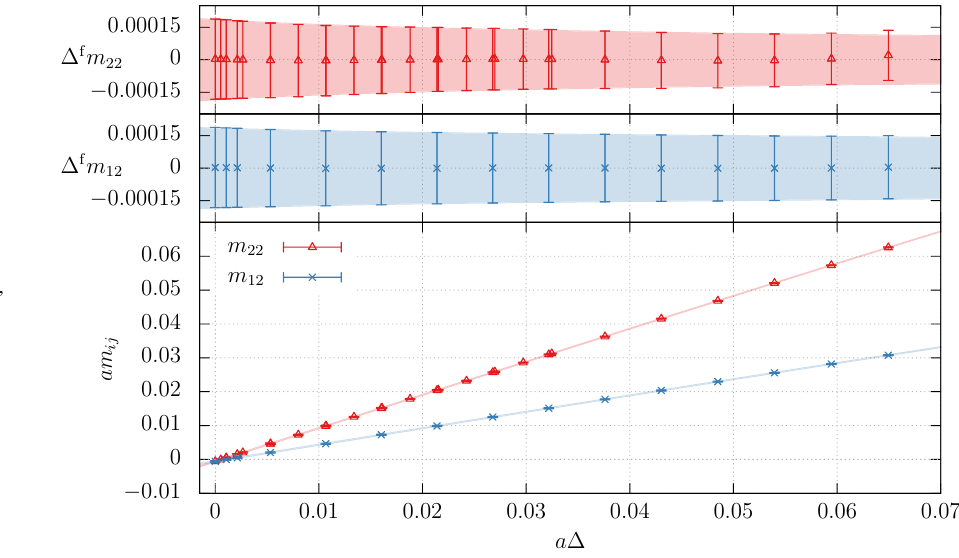
Fig. 2 Lower plot: example of a combined mass fit (ensemble Δ f m B1k4) depicting the fitted data 22 − 0 . points and curves for m 22 and m 12 . Error bars and bands are too small compared to the scale of the plot. The density of m 22 points increases at smaller m 22 , − 0 . due to the inclusion of m 33 results. Upper plots: differences between the measured PCAC masses m ij and the fitted curves, (cid:6) f m = m (κ ) − m ((cid:6)) ij ij ij 2 together with the statistical uncertainties of the data points and the uncertainty band of the curves − 0